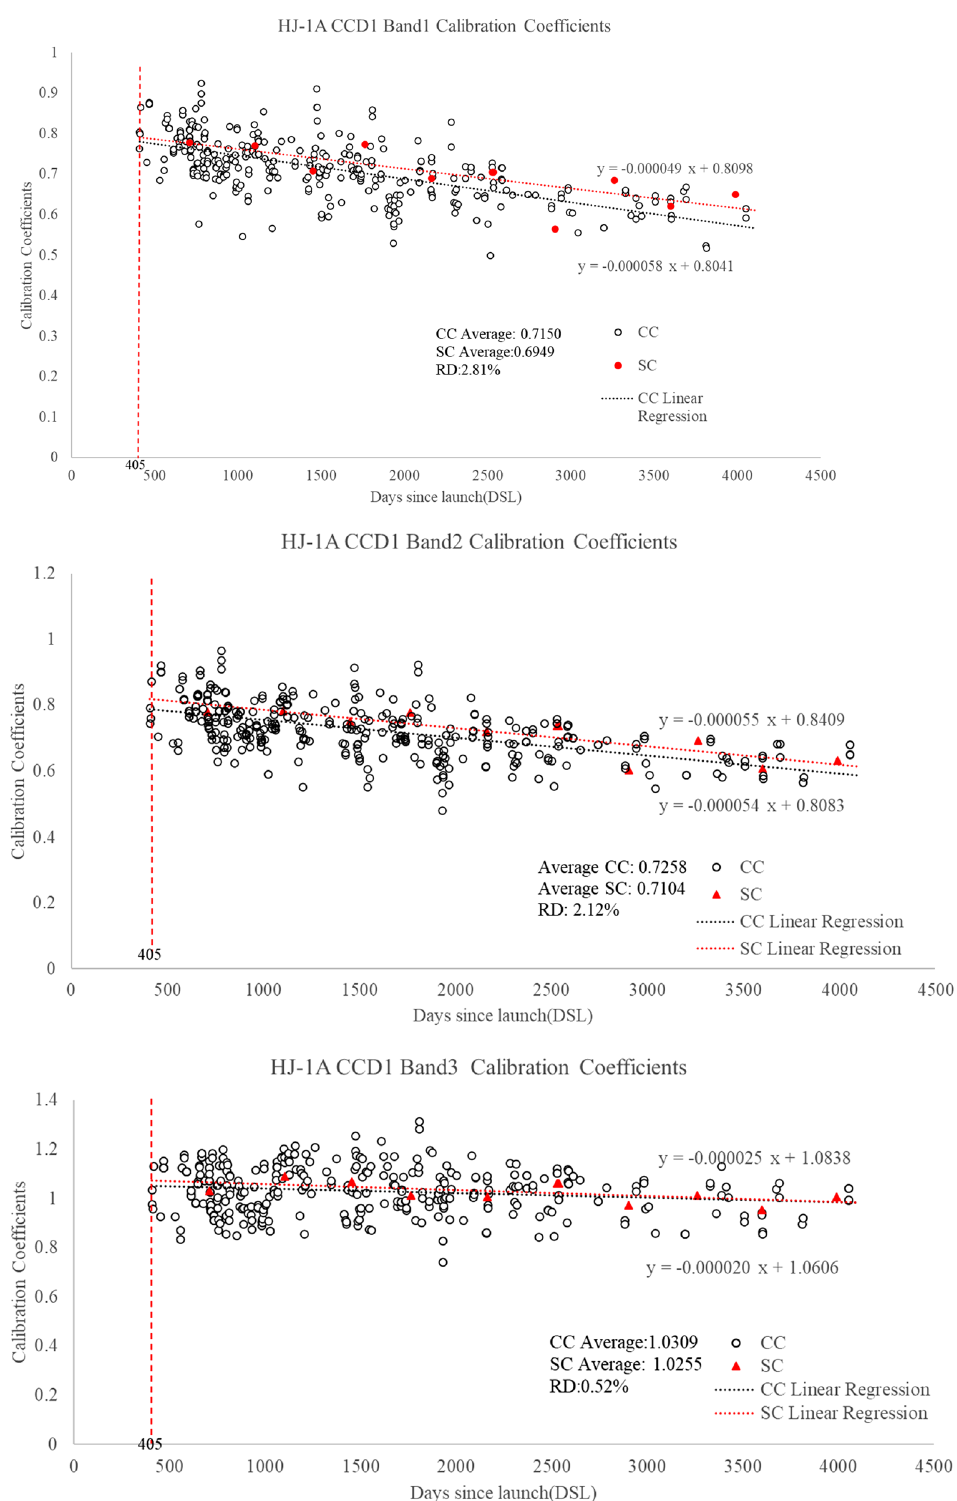
Figure 9. Long-term calibration coefficients for HJ-1A CCD1 bands 1, 2, 3,